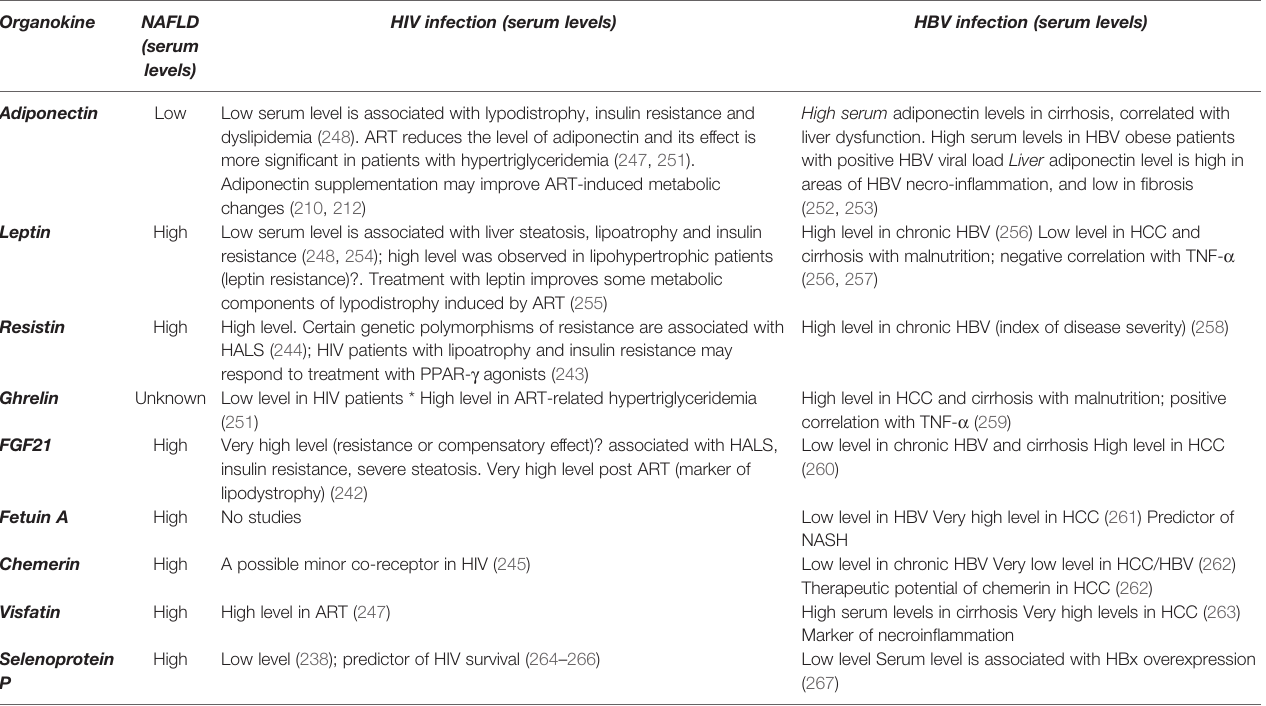
TABLE 5 | The main hepatokines and adipokines discussed in the article and their implications in HIV and HBV infection.